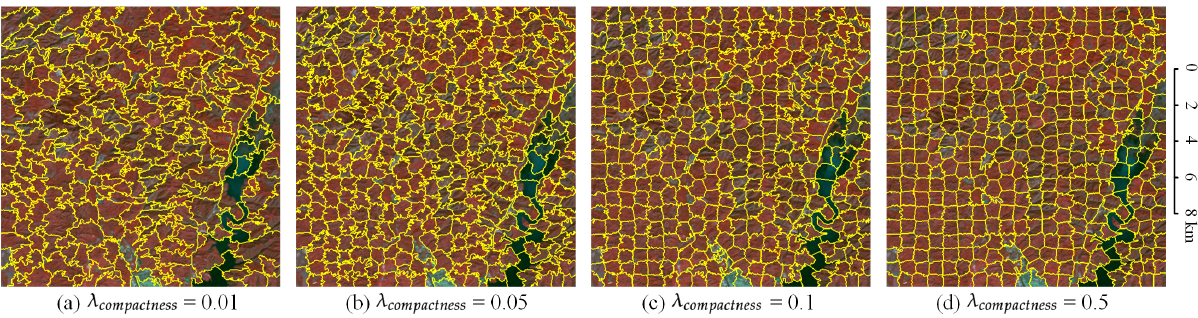
Figure 23. The effect of λ compactness on Landsat images. ( a ) λ compactness is set to 0.01. ( b ) λ compactness is set to 0.05. ( c ) λ compactness is set to 0.1. ( d ) λ compactness is set to